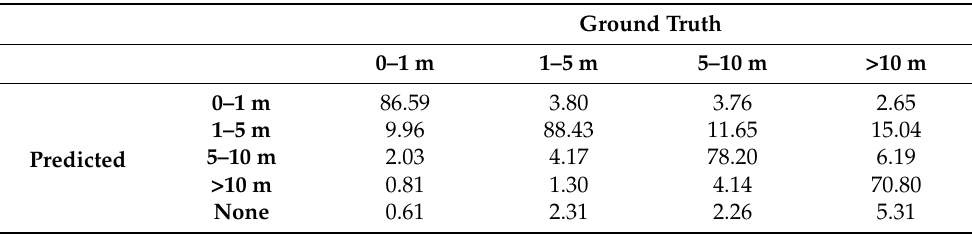
Table 6. Confusion matrix for final road segments classification into one of RSS–D classes presented with